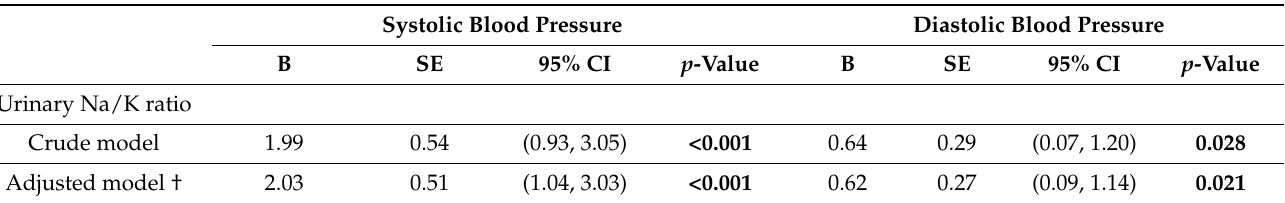
Table 2. The association between changes in the urinary Na/K ratio and blood pressure among older adults.